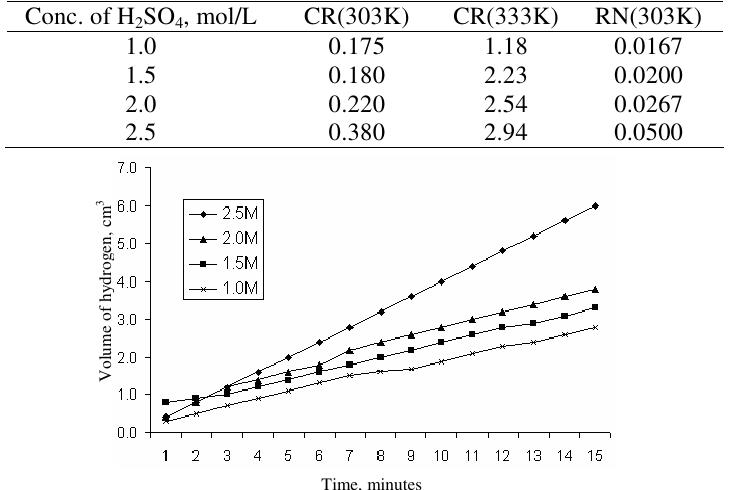
Table 1. Corrosion rate (cm 3 /minute) and reaction number ( ° C/minute) for the corrosion of mild steel in H SO 2 4